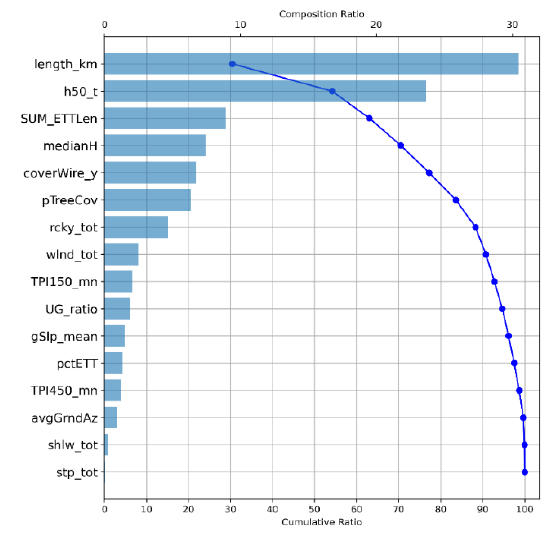
Figure 6. Variable importance with composition ratio and cumulative